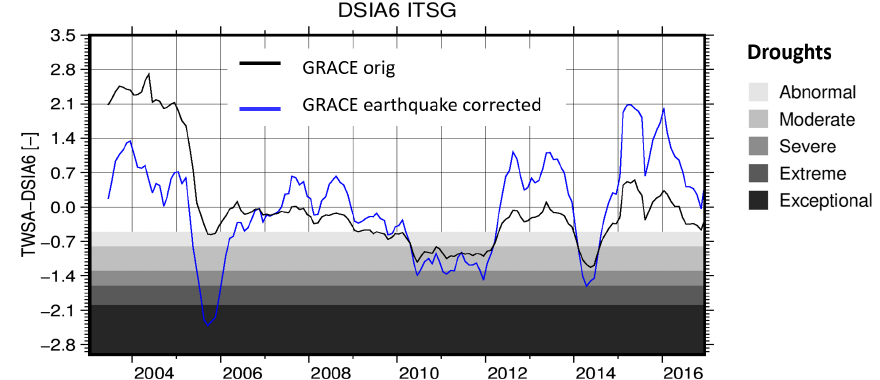
Figure 10. GRACE-derived TWSA DSIA6 over peninsular Malaysia (West Malaysia) shown without (black) and with (blue) earthquake